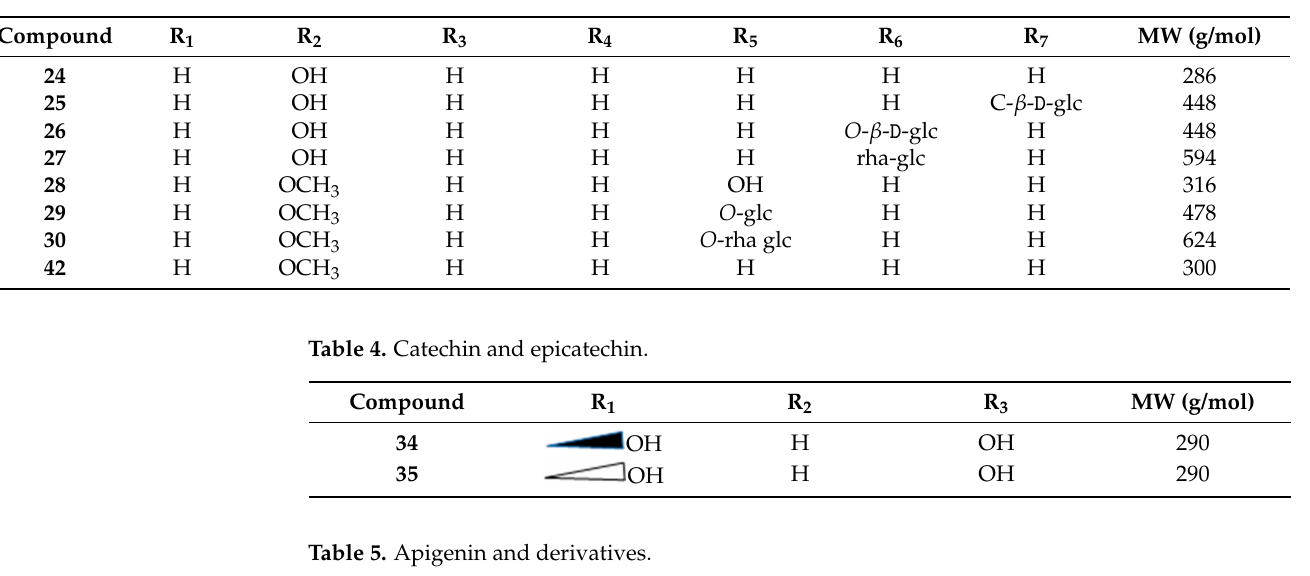
Table 3. Luteolin and isorhamnetin, and derivatives.